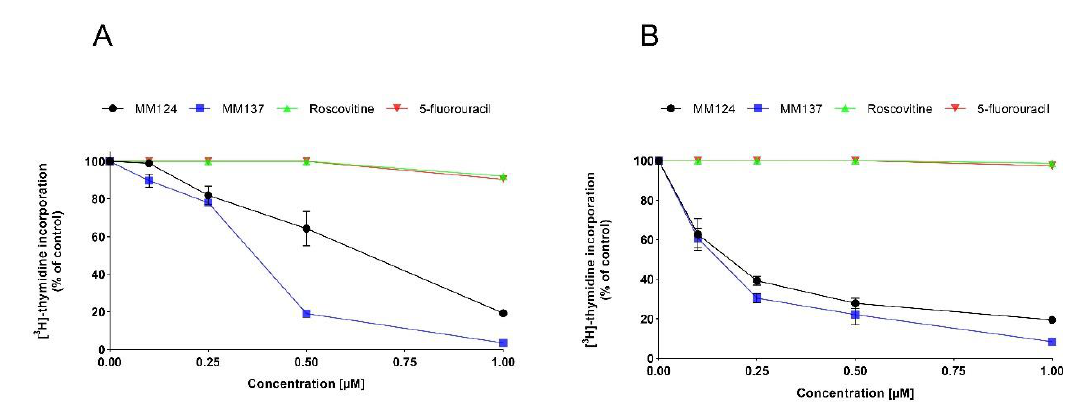
Figure2. Antiproliferativee ff ectsofnovel7-methyl-5-phenyl-pyrazolo[4,3- e ]tetrazolo[4,5- b ][1,2,4]triazine Figure 2. Antiproliferative effects of novel sulfonamide derivatives (MM124, MM137), 5-fluorouracil and roscovitine in DLD-1 ( A ) and HT-29 ( B ) 7-methyl-5-phenyl-pyrazolo[4,3- e ]tetrazolo[4,5- b ][1,2,4]triazine sulfonamide derivatives (MM124, cells after 24 h incubation was measured by inhibition of [ 3 H]-thymidine incorporation into DNA. MM137), 5-fluorouracil and roscovitine in DLD-1 ( A ) and HT-29 ( B ) cells after 24 h incubation was Mean ± SD from three independent experiments done in duplicate are measured by inhibition of [ 3 H]-thymidine incorporation into DNA. Mean ± SD from three independent experiments done in duplicate are presented.